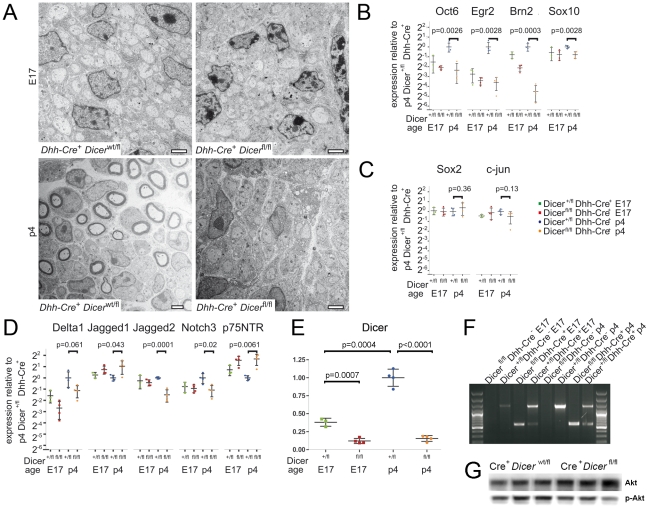
Time course analysis of defective myelination following Schwann cell specific Dicer depletion.Sciatic nerves of embryos (E17) and newborn mice (p4) were analyzed by electron microscopy for morphological effects of Schwann cell-specific Dicer depletion (A), and by quantitative RT-PCR for mRNA expression of factors known to regulate myelination. Number of biological replicates used: Dicerfl/fl Dhh-Cre+ E17 n = 4, Dicerwt/fl Dhh-Cre+ E17 n = 3, Dicerfl/fl Dhh-Cre+ p4 n = 4, and Dicerwt/fl Dhh-Cre+ p4 n = 4 (B–D). No morphological difference was observed before the onset of myelination at E17 between Dicerwt/fl Dhh-Cre+ and Dicerfl/fl Dhh-Cre+ nerves. By p4, myelination had begun in Dicerwt/fl Dhh-Cre+ mice, but not in Dicerfl/fl Dhh-Cre+ nerves. Some unsorted fibers were visible in Dicerfl/fl Dhh-Cre+ nerves. Scale bars = 2 µm (A). Quantitative RT-PCR for mRNA expression in Dicer mutant nerves showed lack of developmental upregulation for activators of myelination. P values for comparisons between p4 controls and mutants were: p = 0.0026 (Oct6), p = 0.0028 (Egr2), p = 0.0003 (Brn2), p = 0.0028 (Sox10; B), no significant difference in expression of suppressors of myelination Sox2 and c-jun (C) and altered expression of Notch signaling components and p75NTR. P values for comparisons between p4 controls and mutants were: p = 0.061 (Delta1), p = 0.043 (Jagged1), p = 0.0001 (Jagged2), p = 0.02 (Notch3), p = 0.0061 (p75NTR; D). Dicer mRNA expression was significantly upregulated upon myelination in Dicerwt/fl Dhh-Cre+ sciatic nerves (p4 in comparison with E17, p = 0.0004). At both time points, E17 and p4, significant Dicer mRNA depletion in Dicerfl/fl Dhh-Cre+ was shown (E17: p = 0.0007; p4: p<0.0001; E). Presence of the recombined Dicer allele in E17 and p4 mice was demonstrated by PCR using primers that differentiate between wild type Dicer and the recombined allele (F). The wild type allele is 1.3 kb in length, and the recombined allele is approx. 500bp (G). Akt phosphorylation and expression were analyzed by Western blot in Dicerwt/fl Dhh-Cre+ compared to Dicerfl/fl Dhh-Cre+ at p4. P-Akt in relation to total Akt was reduced to 62±14% of control level in Dicerfl/fl Dhh-Cre+ at p4. All p values were determined using an unpaired two-tailed student's t-test. All error bars indicate standard deviation.